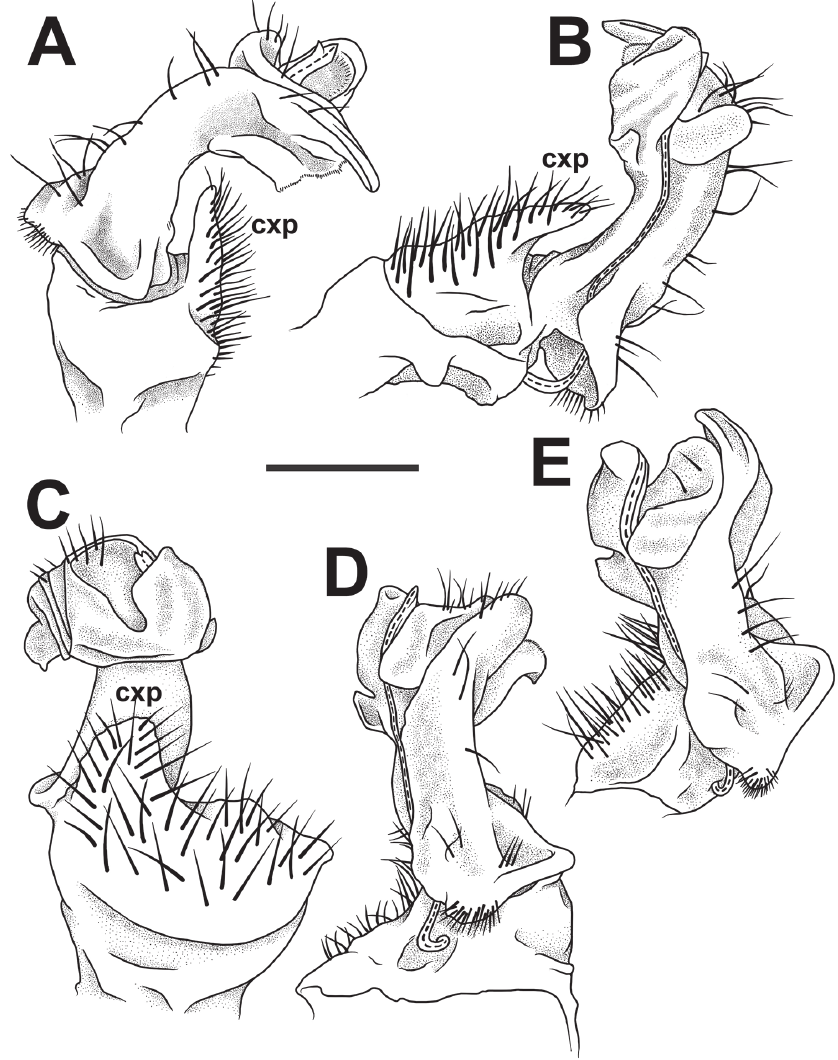
Figure 4. Trichopeltis sutchariti sp. n., ♂ holotype. A–E right gonopod, subfrontal, mesal (mirror image), sublateral, subcaudal and subfrontal views, respectively. Scale bar: 0.4 mm. Del. N.